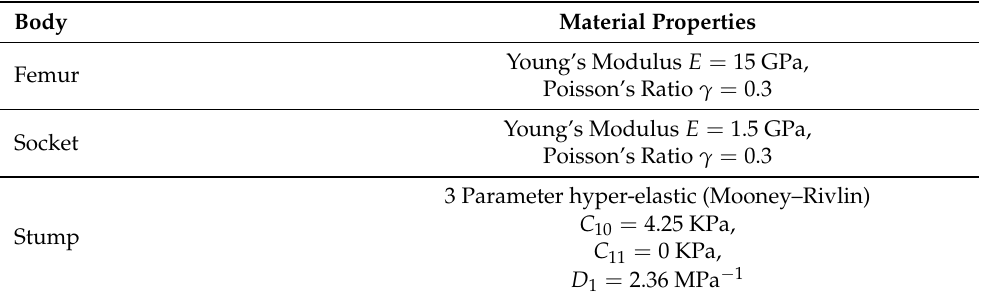
Table 1. Material properties of bodies in ANSYS Mechanical